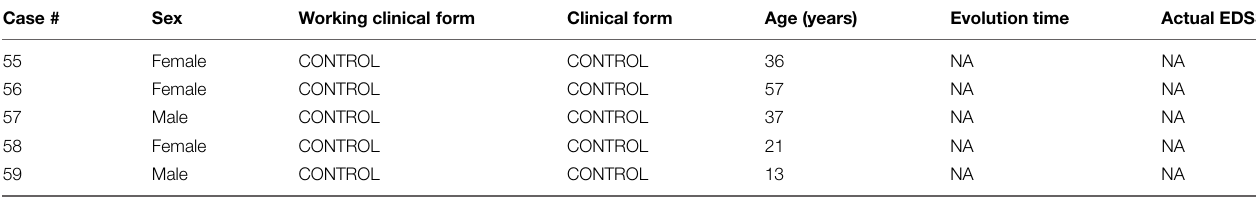
(EUROIMMUN Aquaporin-4 IIFT). Panel I: Anti-AQP4 antibodies observed in the serum of NMO patients (positive sample); Panel II: Absence of